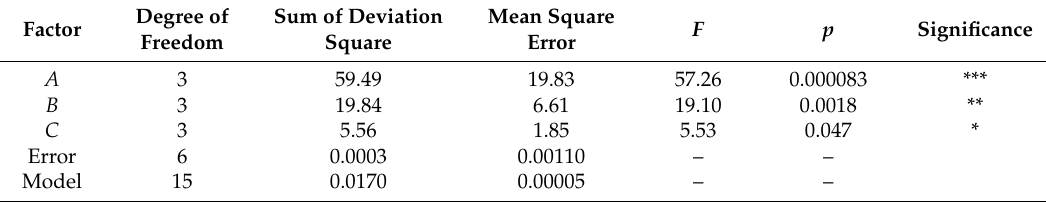
Table 7. Significance analysis for the factors affecting the flexural strength.